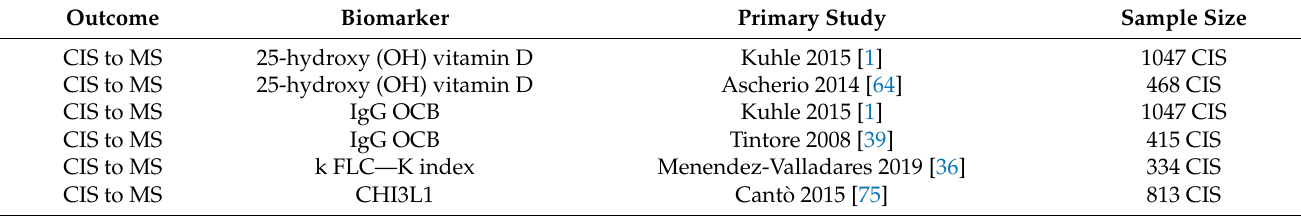
Table 2. Studies with adequate